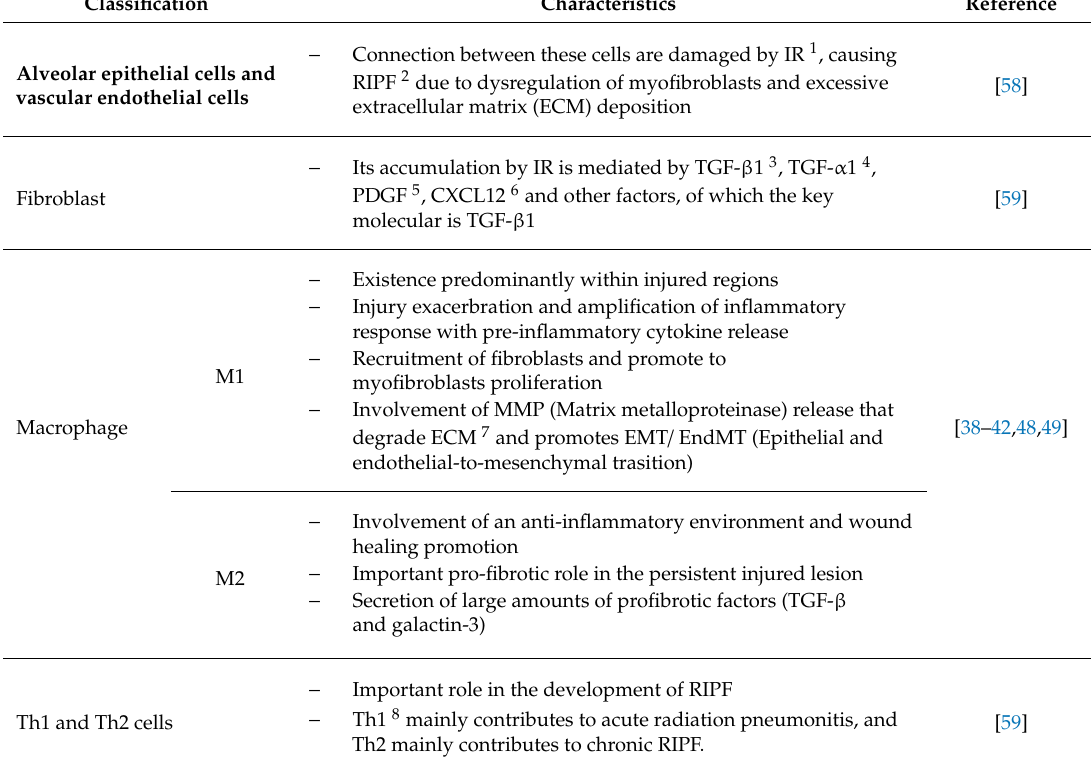
Table 1. Related cells in the development of radiation-induced pulmonary fibrosis (RIPF). Classification